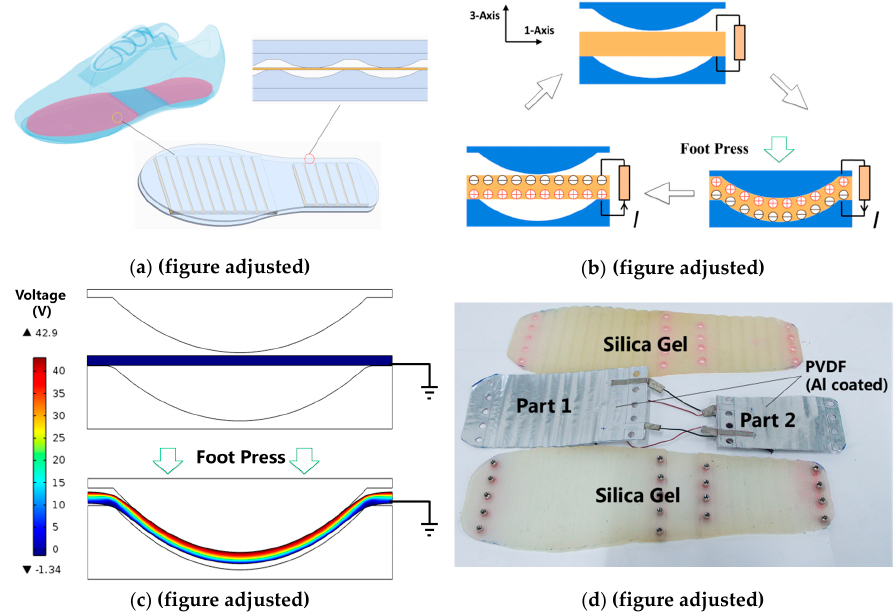
Figure 1. Design of a model of the self-powered insole. ( a ) Application and structure of the designed insole. ( b ) Working mechanism of the self-powered insole. ( c ) Numerical simulation results of the self-powered insole. ( d ) Photo of a fabricated insole.